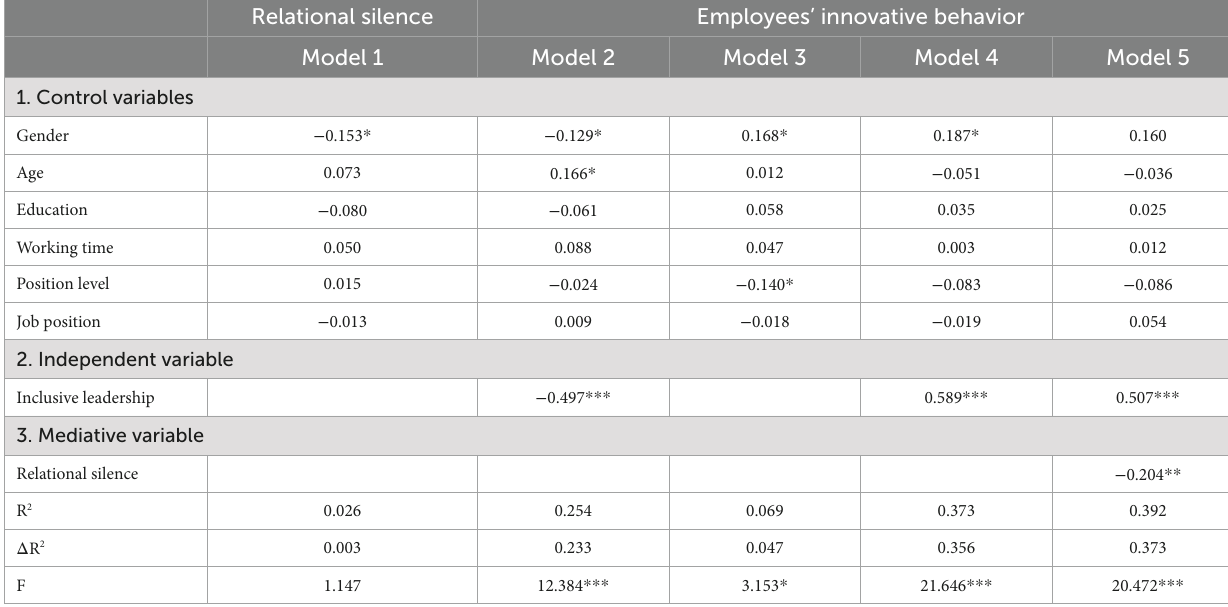
TABLE 3 The results of regression